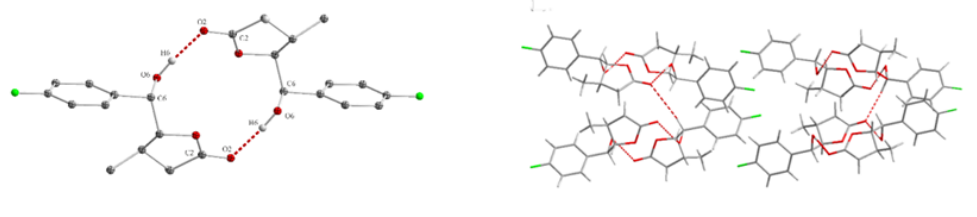
Figure 11. The arrangement of 12b in the unit cell box.